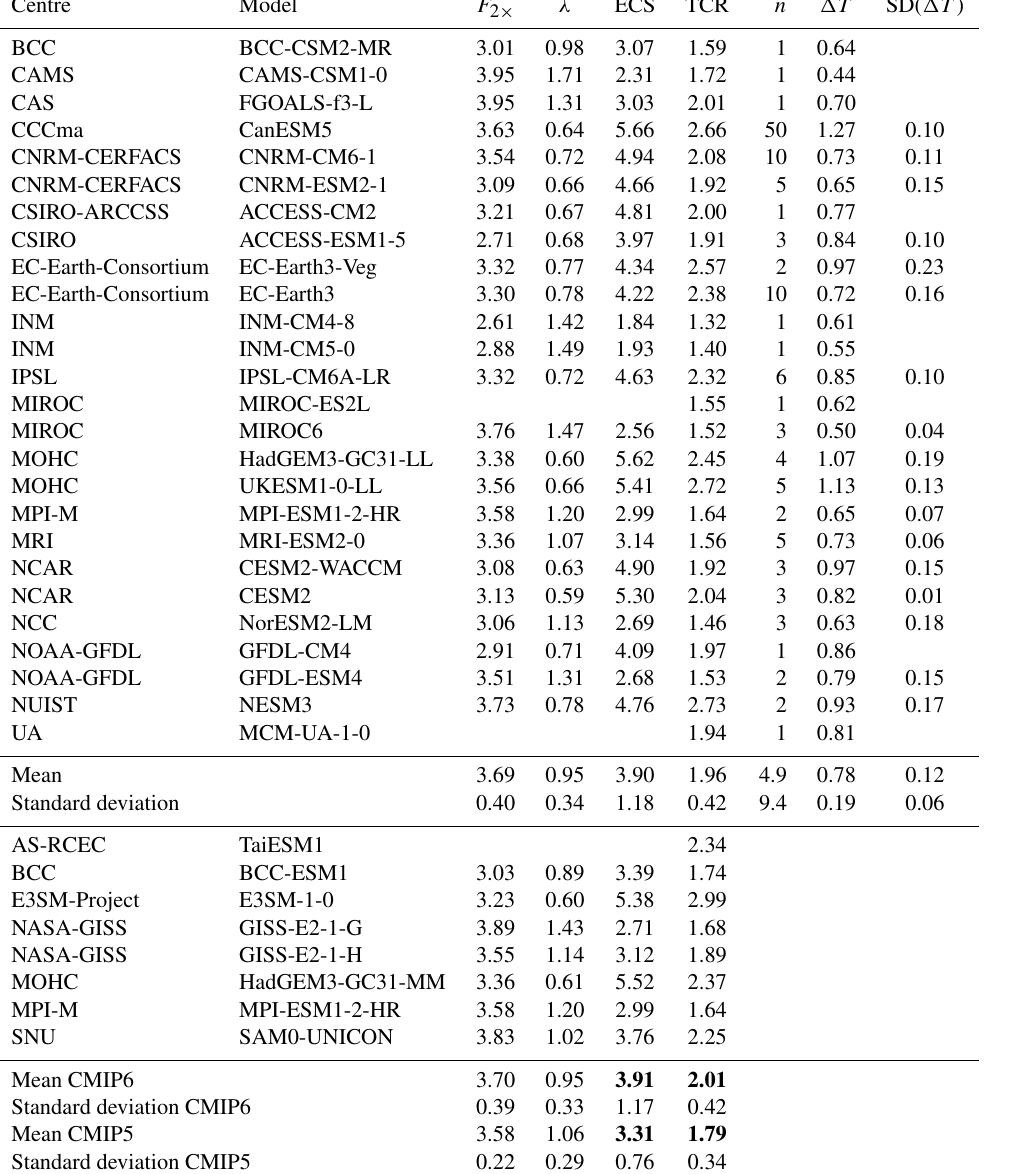
Table 1. List of CMIP6 models used in this study and their effective radiative forcing at CO 2 doubling F 2 × , the climate feedback parameter λ , equilibrium climate sensitivity (ECS) and transient climate response (TCR). Mean values are reported for models with multiple realisations. The values of F 2 × , ECS and λ are computed using the Gregory method (Gregory, 2004). Models above the horizontal line were used in the extended simulations to 2019. Models below the line did not have SSP simulations available at the time of writing. Consistently derived values for CMIP5 are displayed in Table S1 in the Supplement. The ensemble-mean values of TCR and ECS are shown in bold font as these are most relevant to this